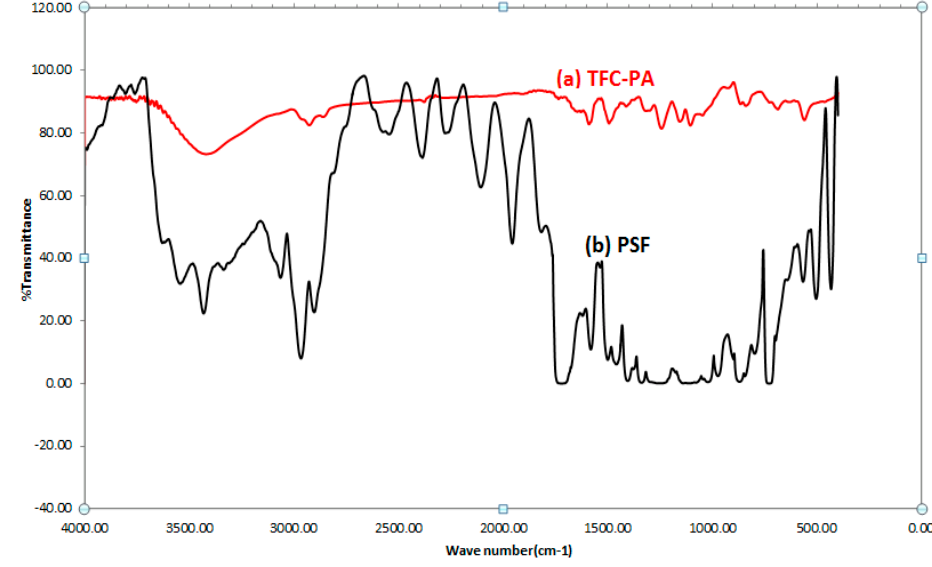
Figure 7. FTIR spectra for TFC-PA membrane and polysulfone (PSF) support layer. Table 2. The main characteristic peaks for PA and PSF.